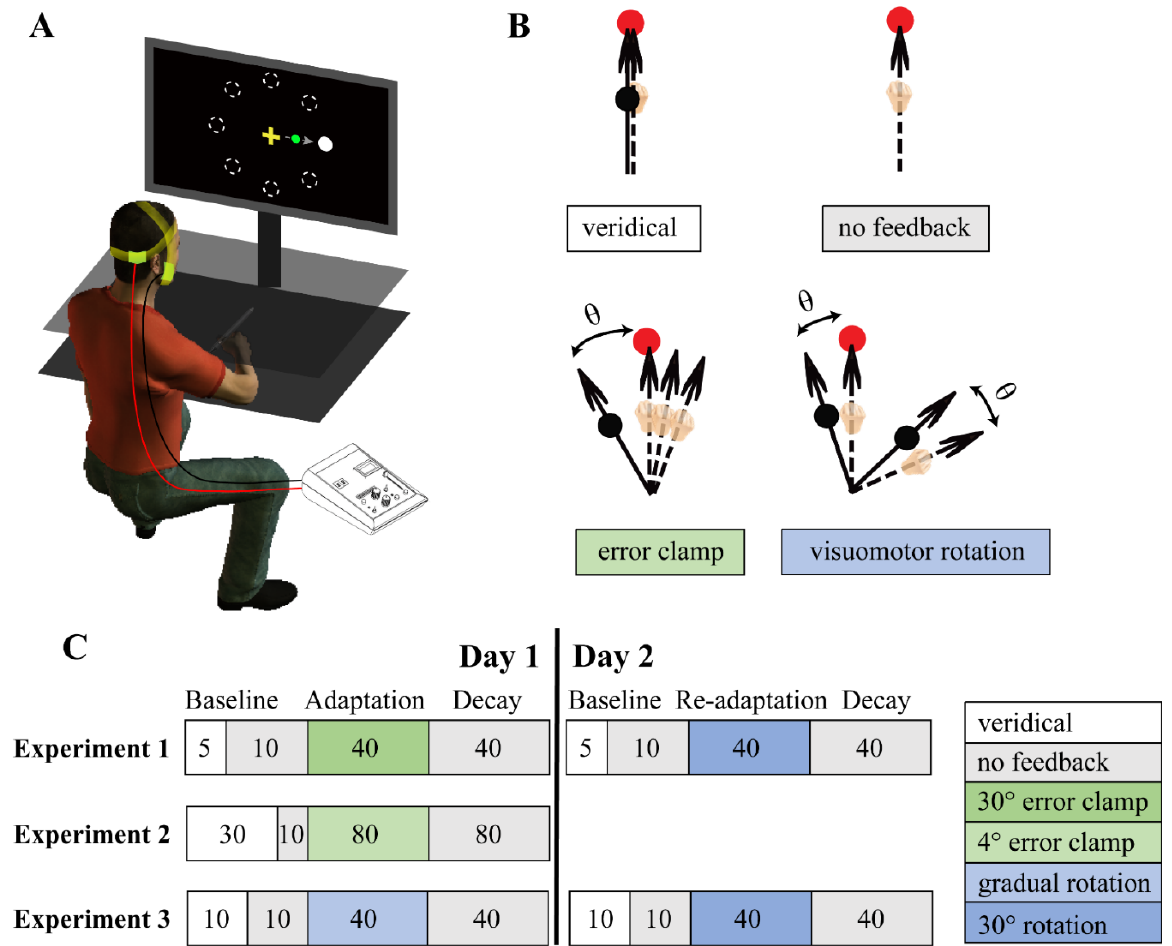
Figure 1. Schematic illustrations of the experimental setup ( A ), movement tasks ( B ), and proce- dures ( C ). ( A ) The seated participant, wearing tDCS electrodes, moves the hand from a center position to an outward target with the guidance of a vertical display. The hand motion is concealed by a blinder placed at the shoulder level and tracked by the hand-held digital pen sliding on a tablet. ( B ) Illustrations of the four trial types used in the experiments. Veridical trials show a cursor whose position is overlaid with the tip position of the hand-held pen. Trials with no feedback do not show the hand cursor during movement. Trials with the error clamp show a cursor moving concurrently with the hand but with an angular deviation. The angular deviation is a fixed counterclockwise rotation angle θ of 30 or 4 ◦ related to the target, depending on the experiment. The unseen hand slowly biases in the clockwise direction as a result of implicit adaptation to the task-irrelevant cursor. The trials with visuomotor rotation show a concurrent cursor whose movement direction is controlled by the actual hand direction but with a counterclockwise rotation angle θ . Differently from the error clamp, this task-relevant cursor’s direction depends on the hand direction ( θ unchanged related to the hand, as shown), and it leads to adaptive changes as the hand moves in the clockwise direction to offset the rotation. ( C ) The illustration of procedures for the three experiments. Each session, either collected in one day or in two consecutive days, has three experimental phases, i.e., the baseline, adaptation (or re-adaptation), and decay phases. The number of trials in each phase, coded by color shades, is also shown for each